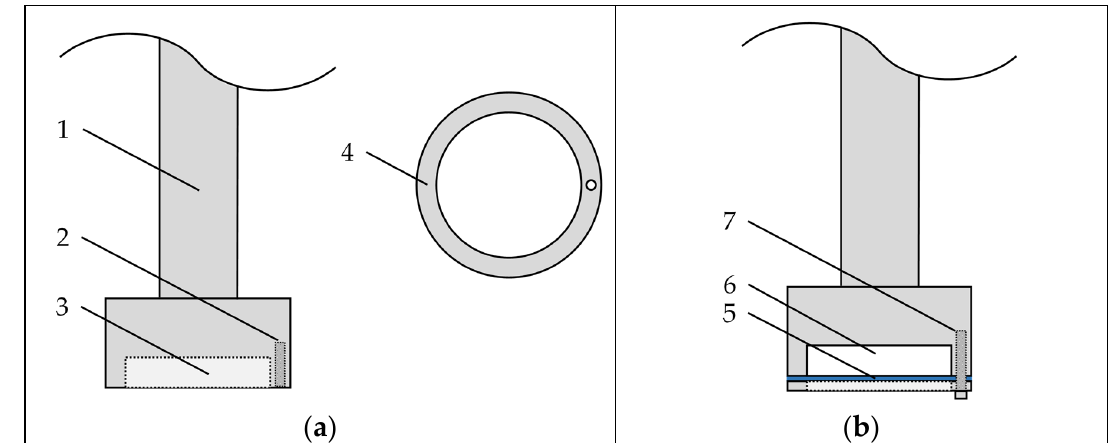
Figure 1. Schematic illustration of the stirring device for determination of the apparent intrinsic dissolution rate. ( a ) Disassembled view with 1. stirring axle, 2. bore for fixation of the cover, 3. cavity for carrier compact, and 4. cover for holding carrier compact in place (top view). ( b ) Assembled view with 5. filter paper, 6. carrier compact, and 7. screw for fixation of cover.